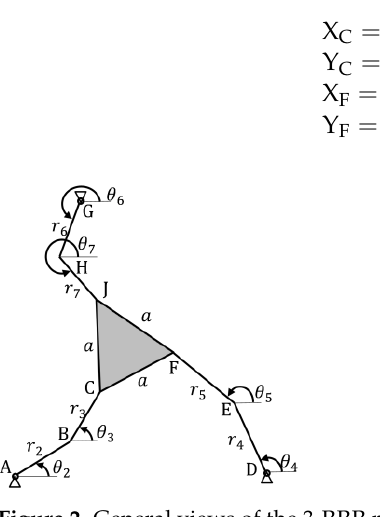
Figure 2. General views of the 3-RRR planar manipulator.